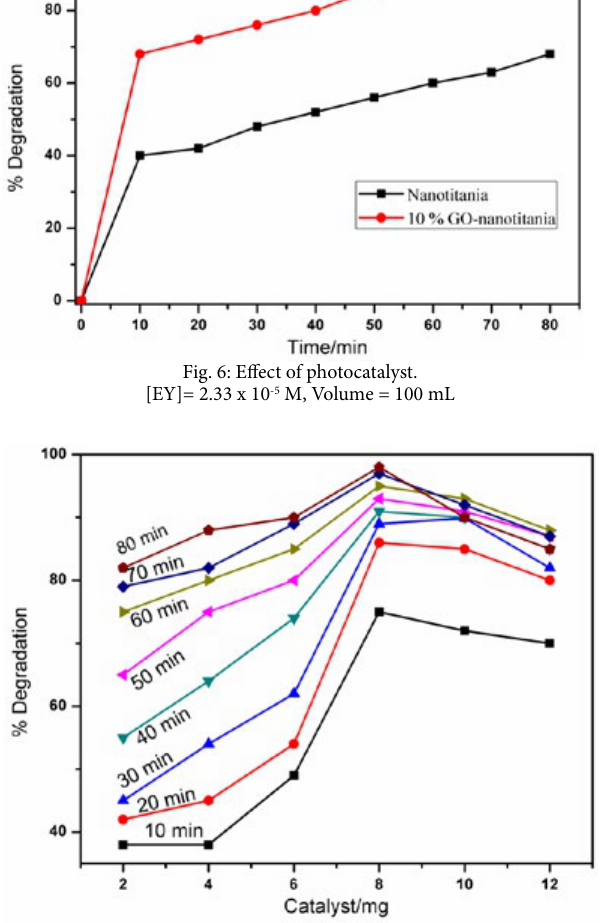
Fig. 7 Effect of photocatalyst dose. Fig. 7: Effect of photocatalyst dose. Catalyst= 10 % GO-nanotitania composite, [EY]= 2.33 x 10 -5 M, Volume = 100 mL